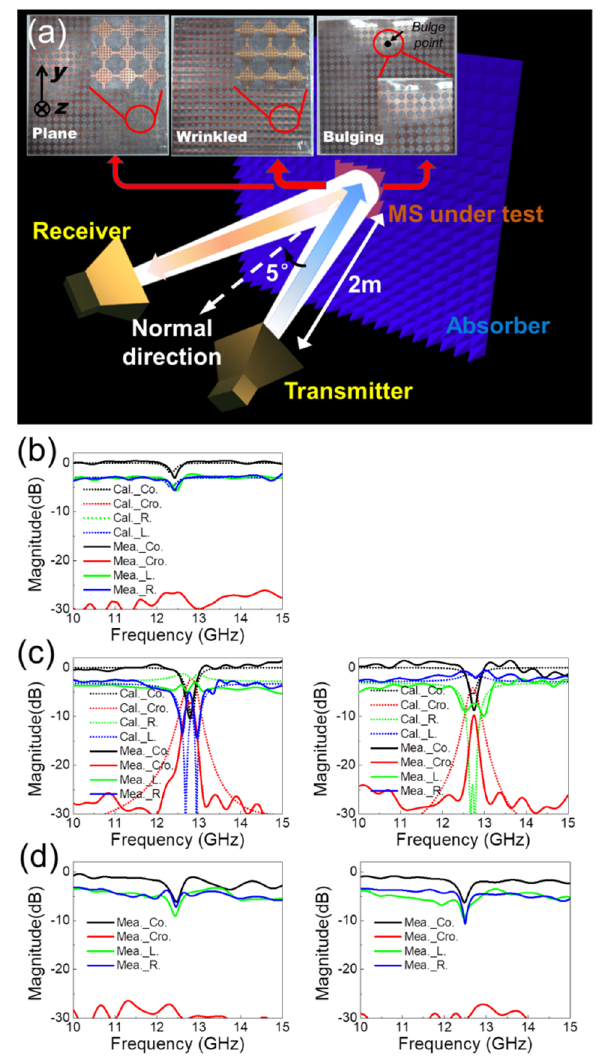
Figure 4. Measurement of the proposed MS. ( a ) Schematic of measurement setup for the cross linear-polarized case, and fabricated MS cases in the planar, wrinkled and bulging strain states. ( b – d ) show the measured results for the planar, wrinkled and bulging MS, respectively, with the corresponding simulation results depicted for